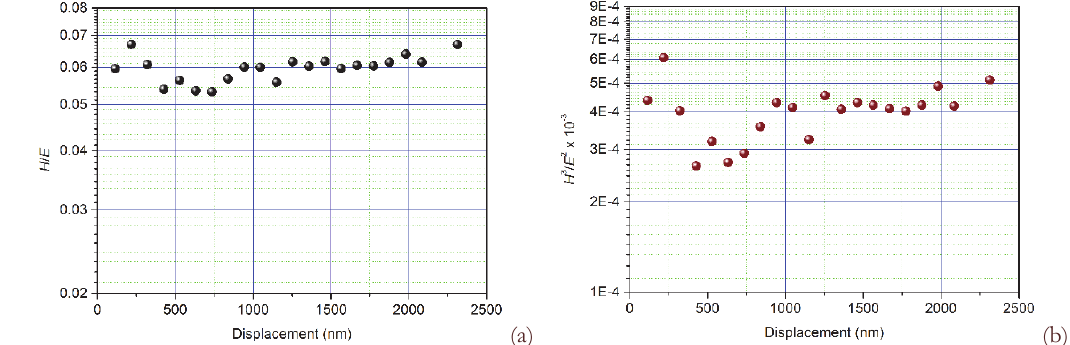
Figure 12: (a) H / E and (b) H 3 / E 2 of MWCNT/PP 2 wt% specimen.